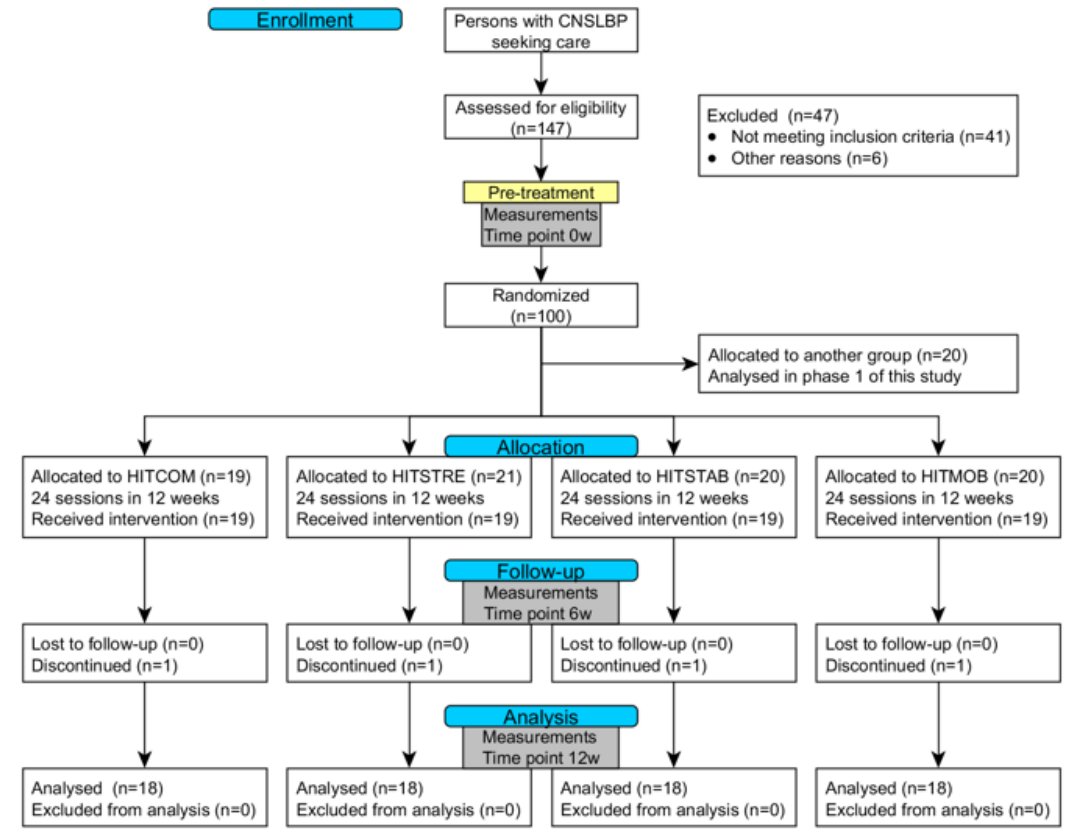
Figure 1. CONSORT flowchart of the research design. Abbreviations: CNSLBP = chronic nonspecific low back pain; HITCOM = high-intensity cardiorespiratory training combined with high-intensity general resistance and high-intensity core strength training; HITSTRE = high-intensity cardiorespiratory training combined with high-intensity general resistance training; HITSTAB = high-intensity cardiorespiratory training combined with high-intensity core strength training; HITMOB = high-intensity cardiorespiratory training combined with trunk mobility exercises.